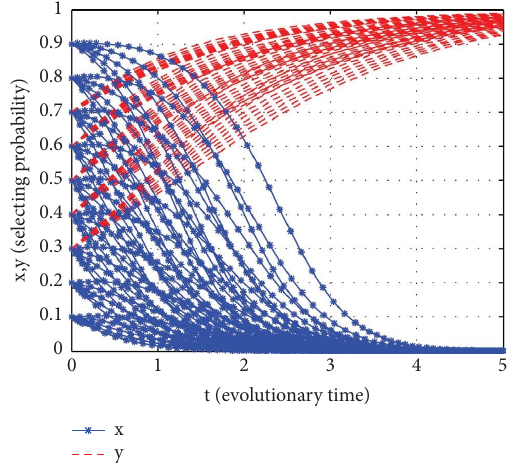
Figure 5: Te evolutionary consequences of Proposition 2 (b).